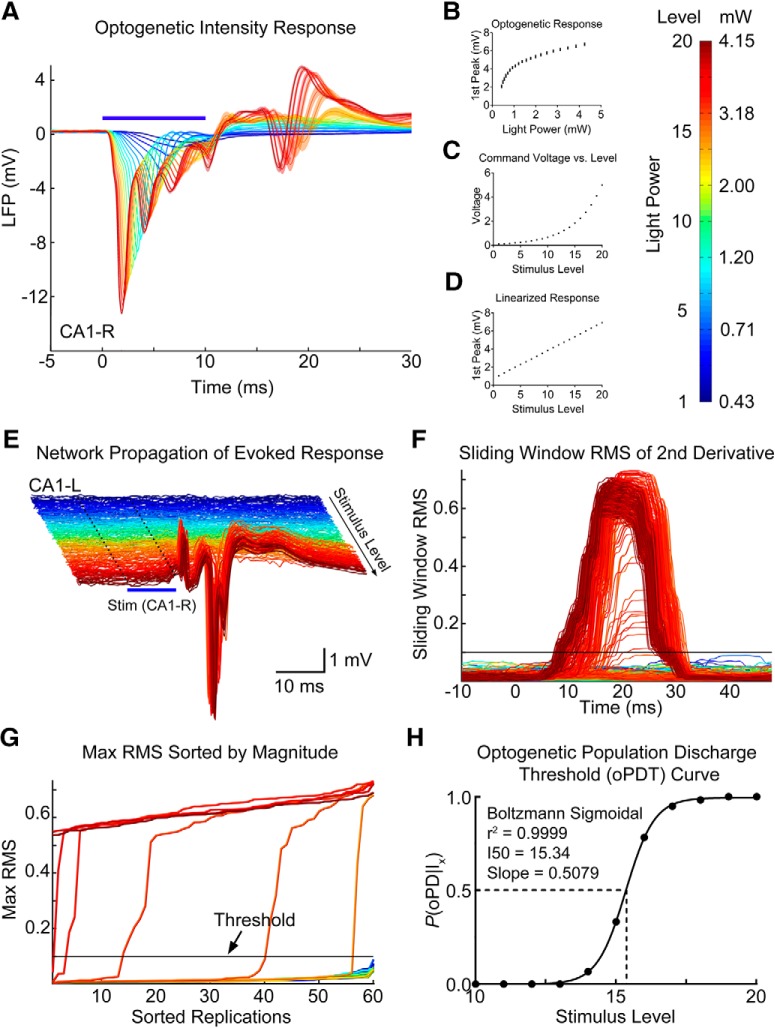
Summary of the oPDT procedure. A, Average LFP response to optogenetic activation in CA1 at varying light intensities. Shaded bars = 95% CIs. B, The short latency LFP response was used as an approximation of ChR2-mediated current to generate a light intensity-response curve. Mean and SD are displayed. C, A series of light intensities was chosen to produce a linearized optogenetic response (D). E, The network propagation of evoked activity from the stimulation site (CA1-R, blue bar) to CA1-L. Individual replicates plotted as bandpass filtered (5–300 Hz) traces. Colors correspond to the level of the light stimulus (shown in mW on color bar); 20 levels × 60 replicates = 1200 total stimuli. ISI = 3 s. Note high amplitude PDs. F, Sliding window RMS of the 2nd derivative calculated from E. Horizontal line indicates the threshold. G, Max RMS (within time window) for each light level sorted by magnitude. Threshold is set in the steep part of the curve. H, oPD ratio (oPDs/total stimuli) plot fit by the Boltzmann sigmoid allows for calculation of an I50, or the LED power at which 50% of the stimuli produce a oPD.